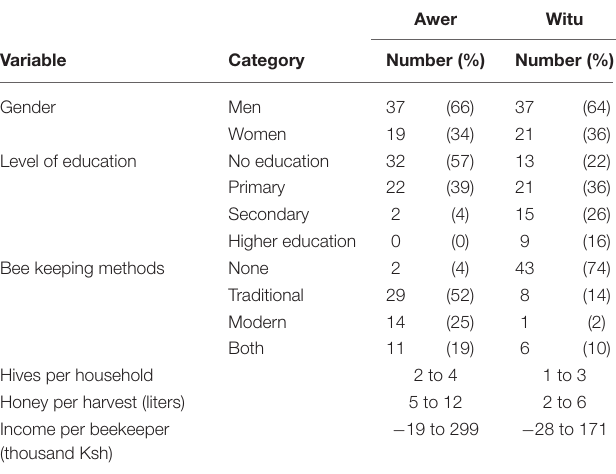
TABLE 1 | Summary of the baseline survey results for net income from beekeeping in Witu and Awer.